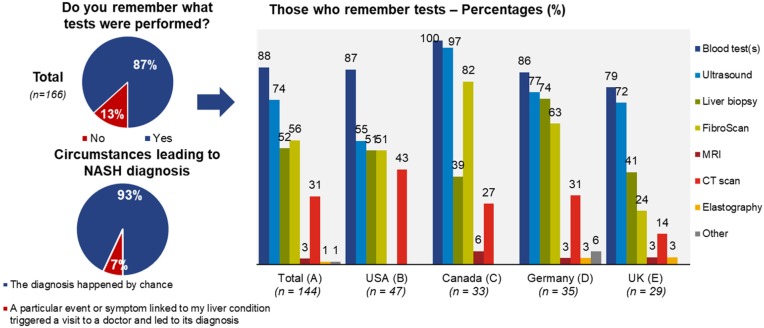
Overview of clinically confirmed or suspected NASH diagnosis across countries.